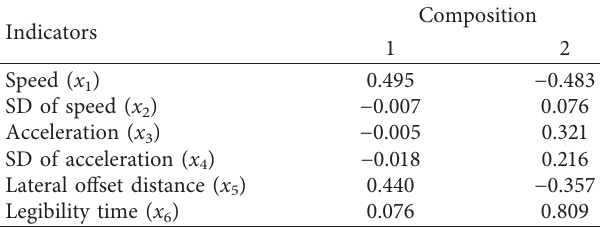
Table 7: Component score coefficient matrix.